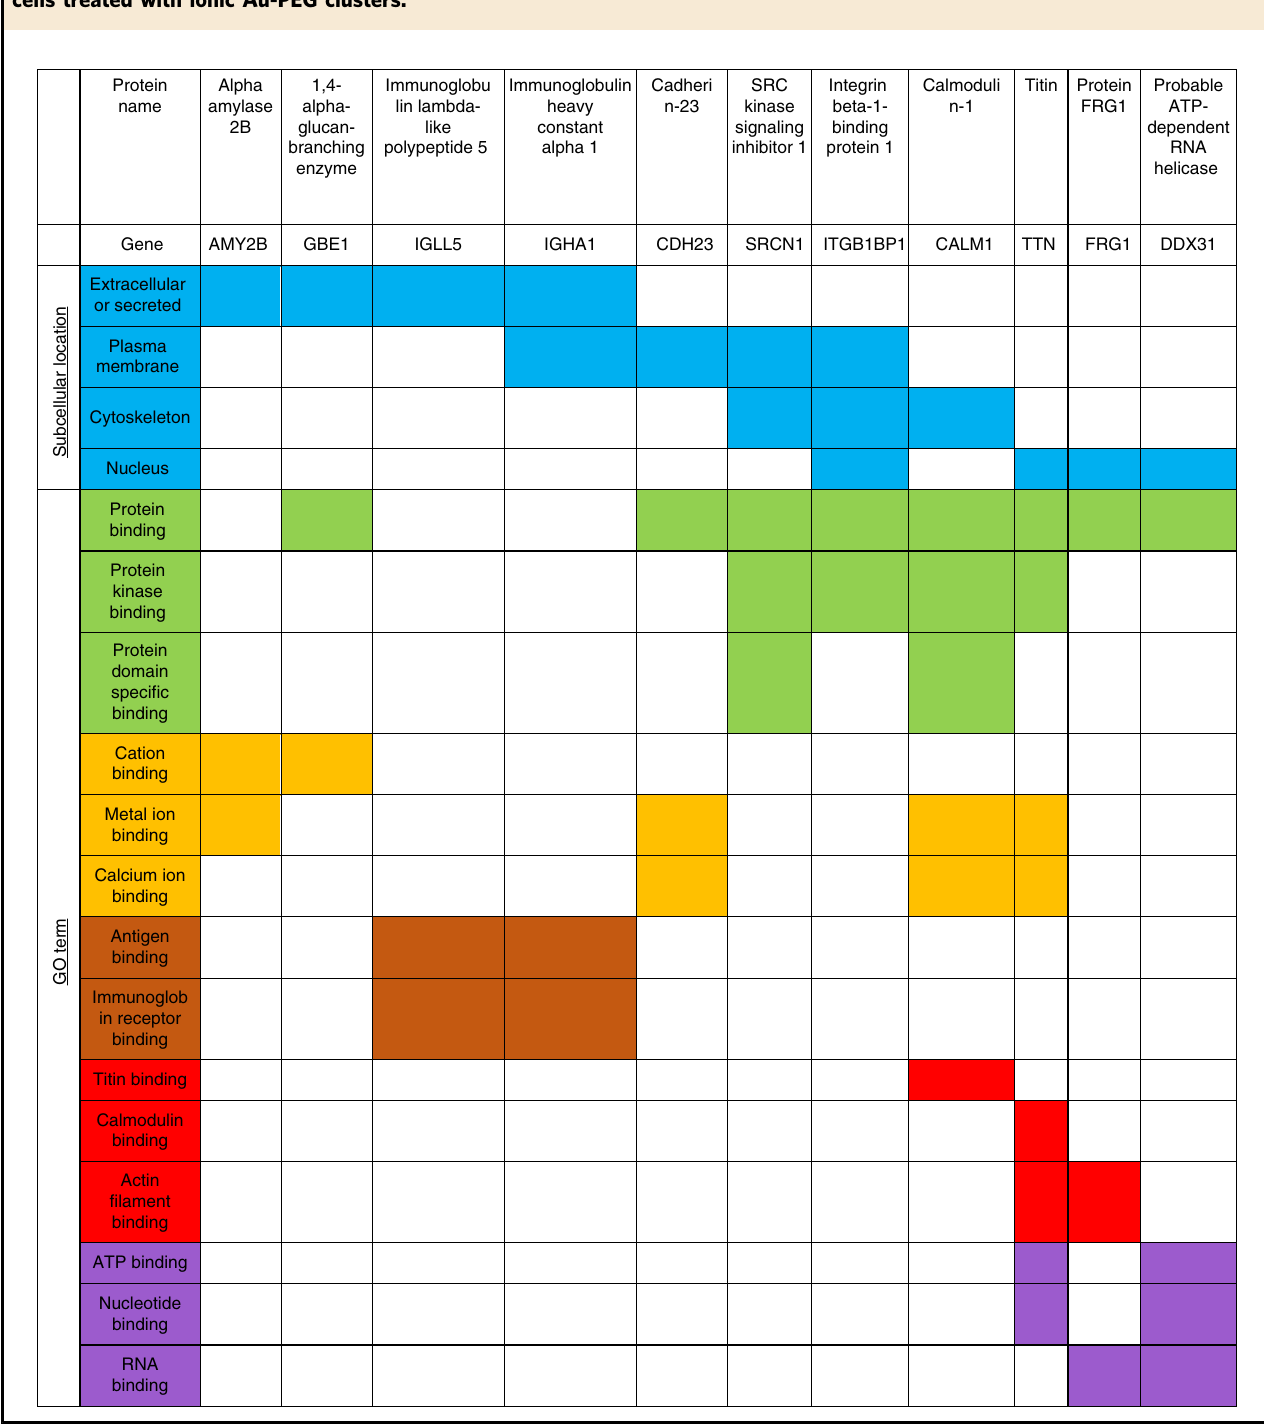
Table 1 Proteins adhered to intracellularly formed gold nanoparticles identi fi ed through LC – MS of the nuclear fraction of MCF-7 cells treated with ionic Au-PEG